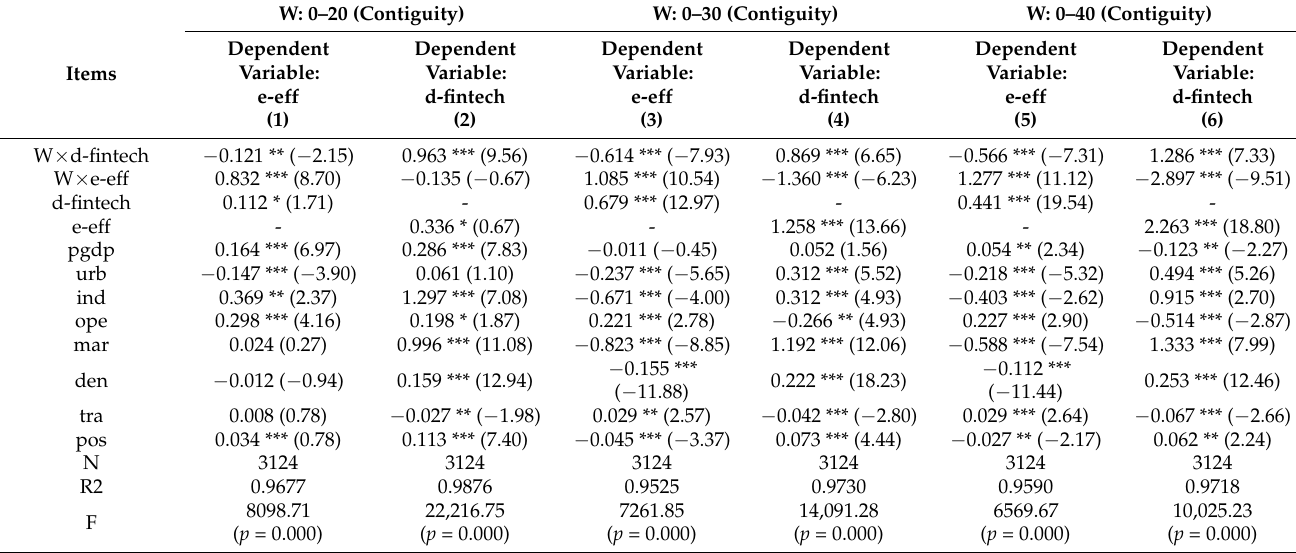
Table 7. Results of robustness test of contiguity spatial weighting